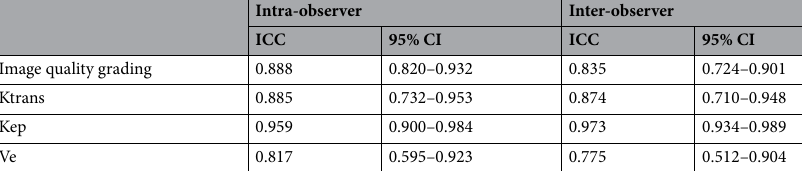
Table 3. Intra- and inter-observer variability of image quality grading and perfusion parameters. ICC intraclass correlation coefficient; CI confidence interval.